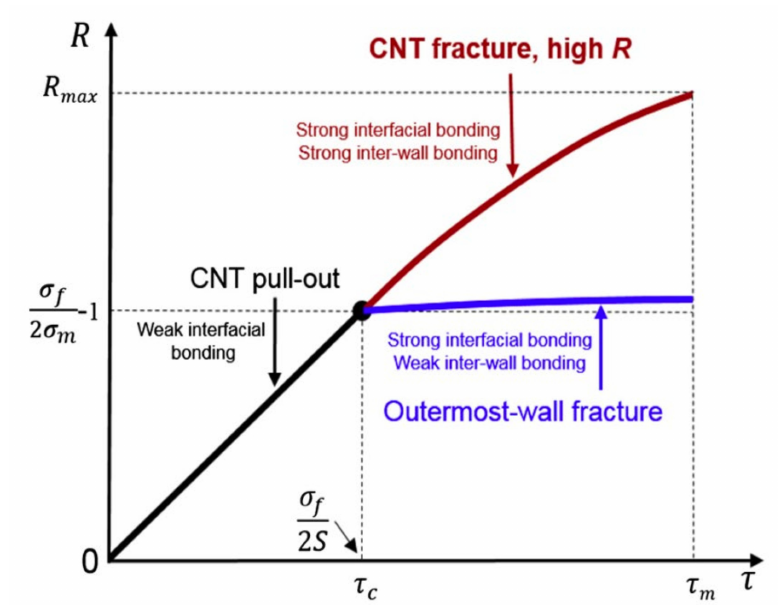
Figure 8. Effect of the CNT failure mode on the strengthening efficiency (R) of composites as a function of interfacial stress (t) between CNT and matrix based on shear–lag model. Load transfer strengthening in carbon nanotube-reinforced metal matrix composites via in situ tensile tests; σ m is the matrix yield strength; σ f is the CNT yield strength and S is the aspect ratio of the CNT. Reproduced from [69] with permission from Elsevier, 2015.